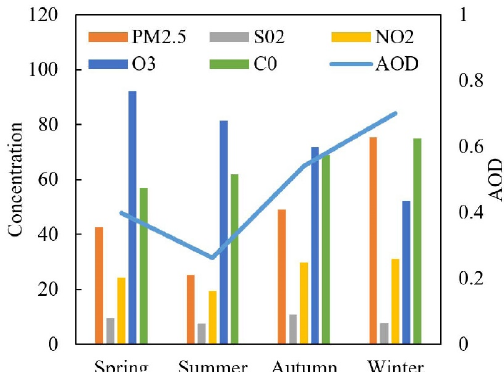
Table 2. The partial correlation coefficient between AOD and PM2.5, SO 2 , NO 2 , O 3 , and CO. AOD and PM2.5 AOD and SO 2 AOD and NO 2 AOD and O 3